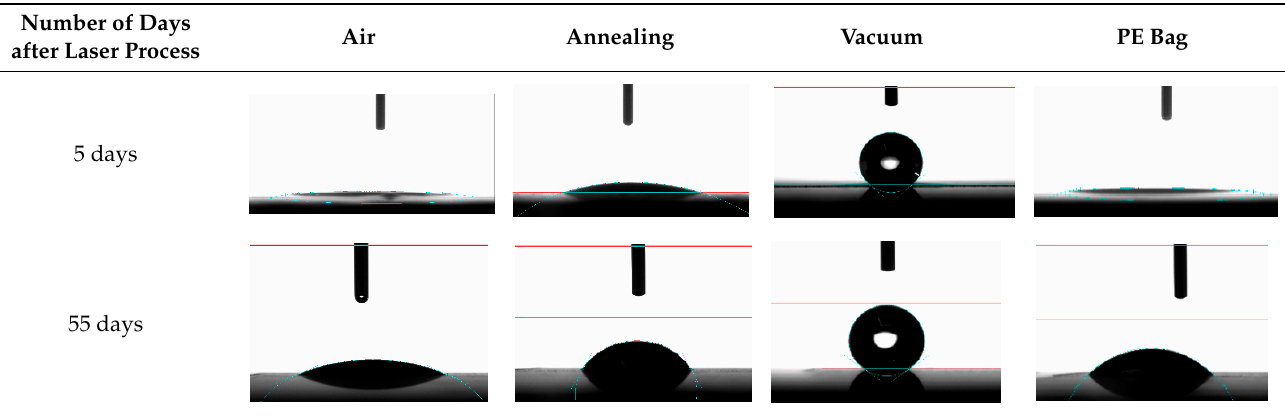
test period and after 55 days it was highly hydrophilic with a CA of 22°.